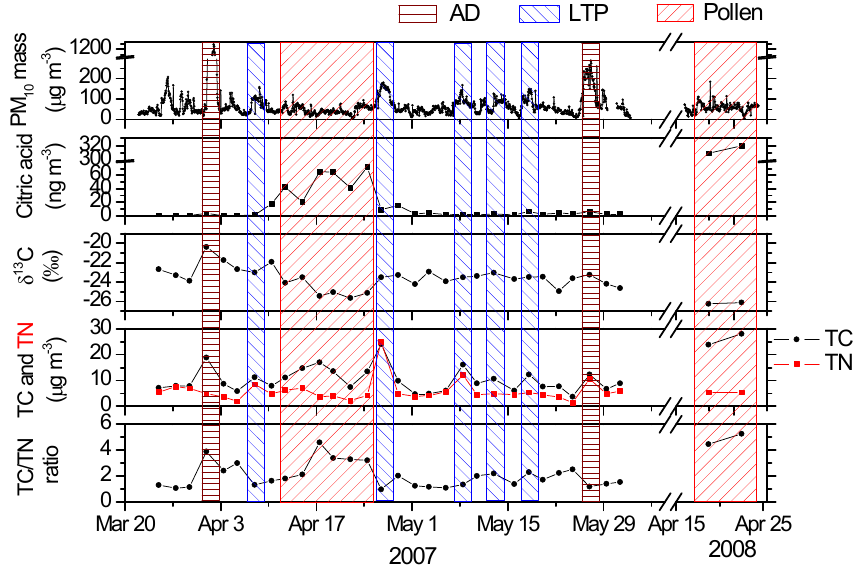
Fig. 3. Temporal variations of mass concentrations of PM 10 , citric acid, total carbon (TC), and total nitrogen (TN), carbon isotope ratios of TC ( δ 13 C TC ), and TC/TN ratios at the Gosan site during 23 March to 1 June 2007 and 16–24 April 2008. LTP represents the long-range transported pollution episode. AD+LTP and pollen represent Asian dust companying LTP and airborne pollen episodes, respectively. Mass concentration of citric acid is obtained from Jung and Kawamura (2011).